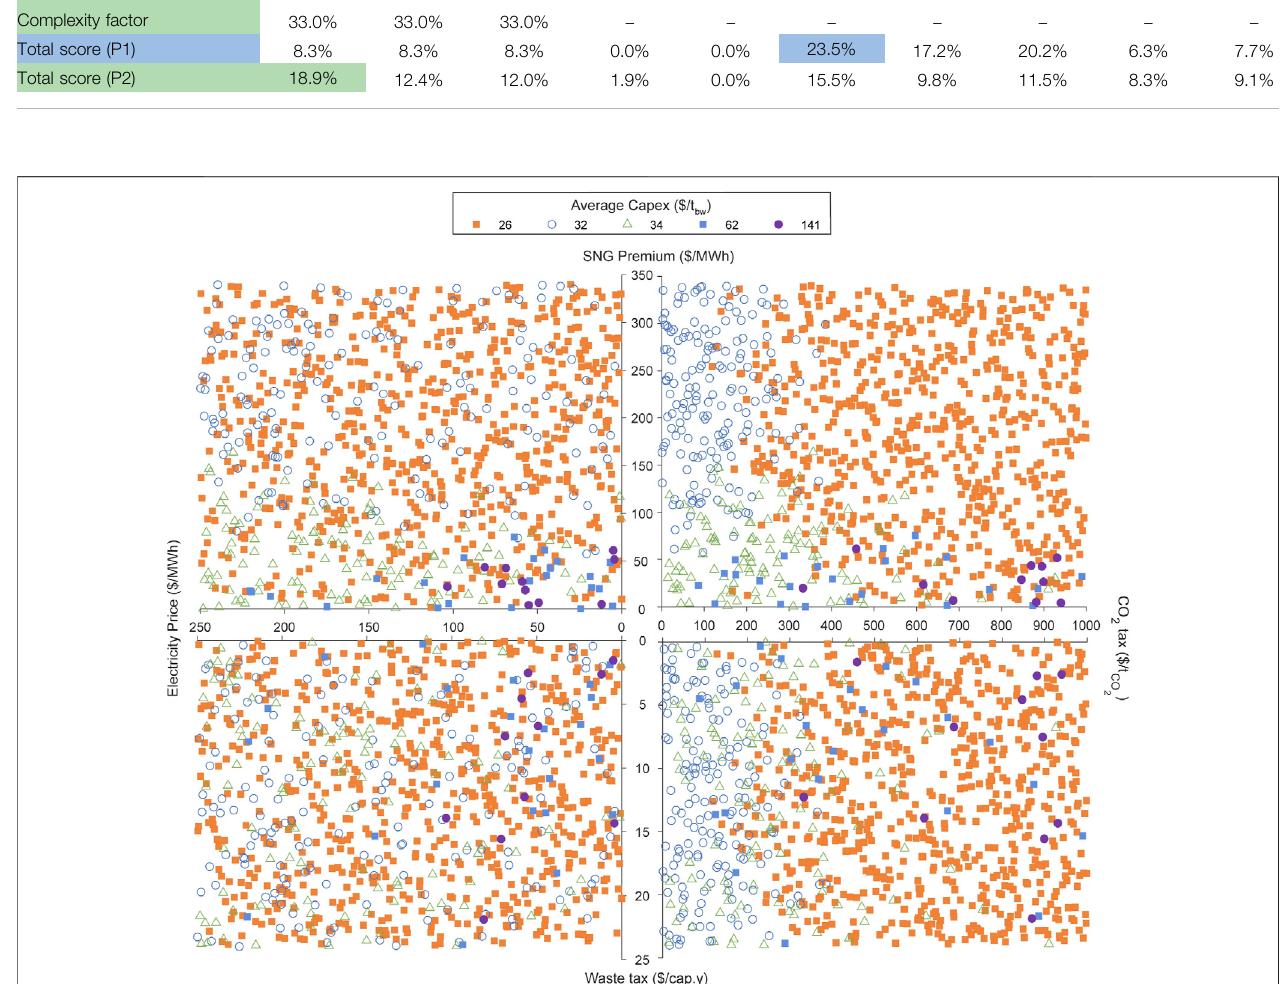
FIGURE 8 | Solutions achieving the lowest total cost for different parameters combination. Symbols represent design con fi gurations labeled according to their average capex ($/t bw ).